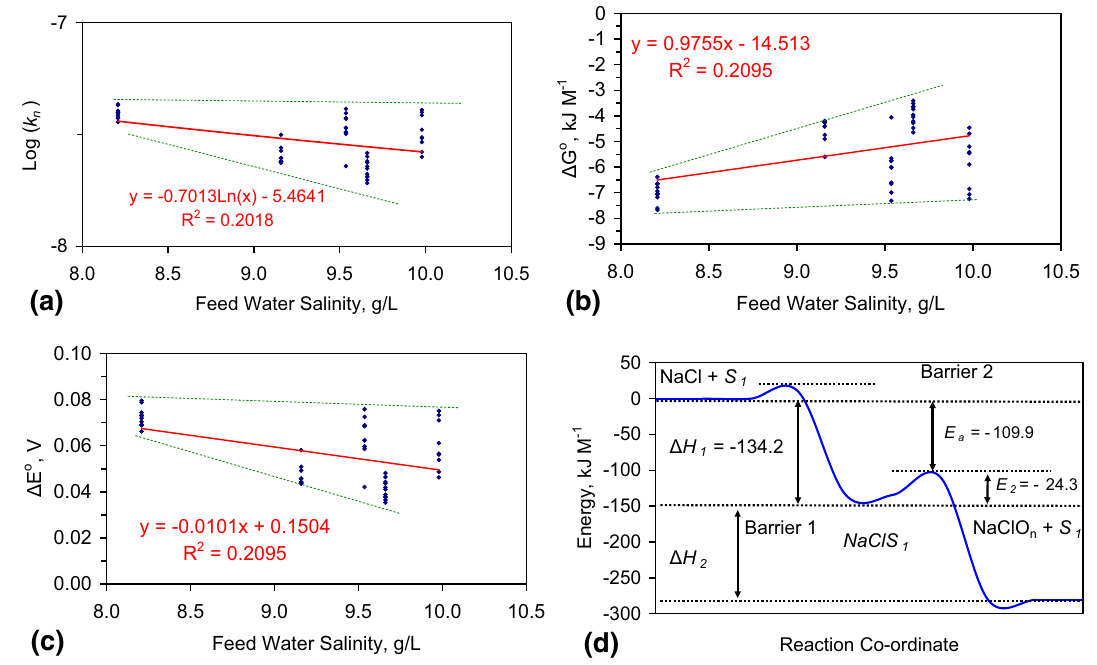
Fig. 6 Catalyst A: interpreted thermodynamic parameters. a Equi- librium constant versus salinity. b Gibbs free energy versus salinity (trials ST1a–ST5j (50 trials Antia 2015b). c Standard potential ver- sus salinity (trials ST1a–ST5j (50 trials Antia 2015b). d Interpreted reaction co-ordinate versus energy diagram for the generic